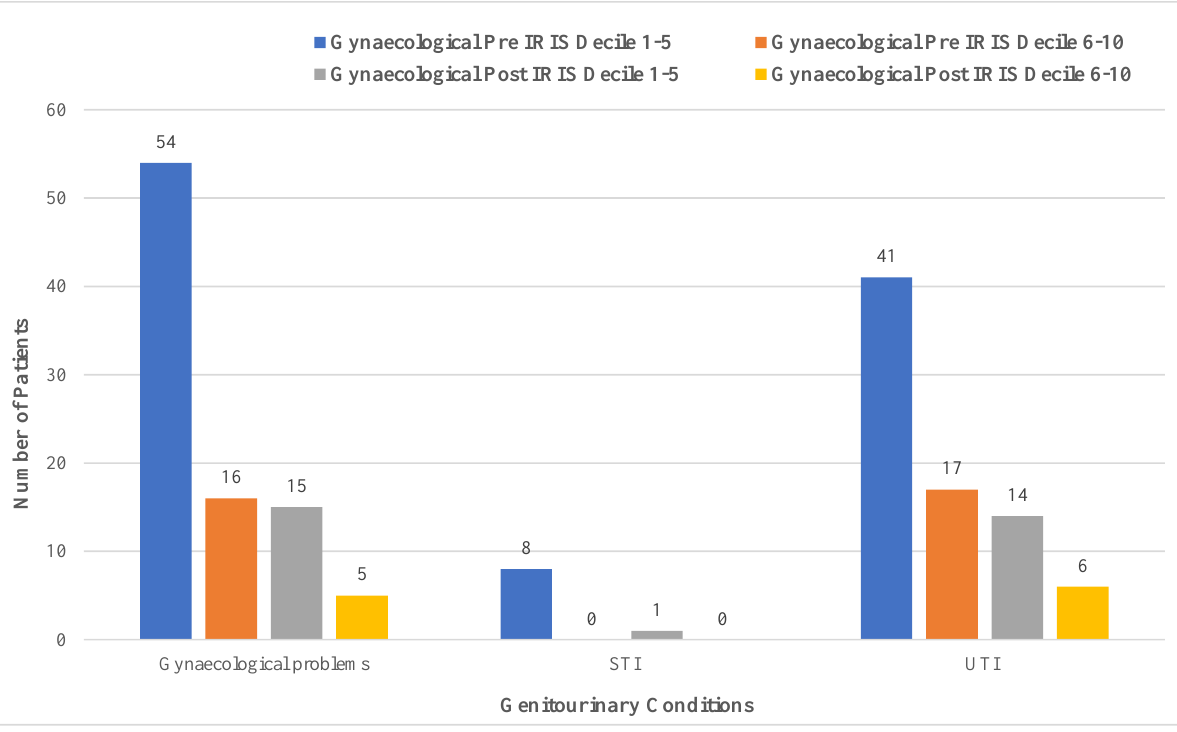
Figure 5. Comparison of genitourinary conditions and deprivation decile ( n = 250). Figure 6 illustrates the health conditions associated with pain, fatigue and irritable bowel syndrome (IBS). The health data were mapped according to decile information of the 250 patients, and all dropped post-IRIS intervention. Although Figure 6 outlines spe- cific health conditions associated with pain, these conditions are portrayed collectively as pain in the following recorded data. Pre-IRIS in deciles 1 – 5, 52% ( n = 131) of the sample had recorded pain, 5% ( n = 12) for recorded for chronic fatigue and 5% ( n = 13) recorded for IBS. Pre-IRIS in deciles 6 – 10, 14% ( n = 36) had pain recorded, 0.4% ( n = 1) chronic fa- tigue and 3% ( n = 8) had IBS recorded. Post-IRIS in deciles 1 – 5, pain, chronic fatigue and IBS were recorded at 16% ( n = 40), 3% ( n = 4) and 2% ( n = 4), respectively. Post-IRIS in deciles 6 – 10, pain, chronic fatigue and IBS were recorded at 3% ( n = 8), 0.4% ( n = 1) and 1% ( n = 2), respectively.